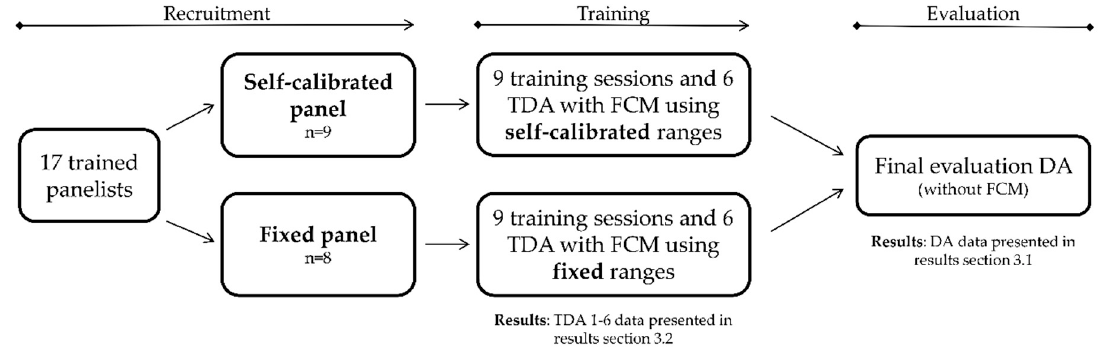
= training descriptive analysis.